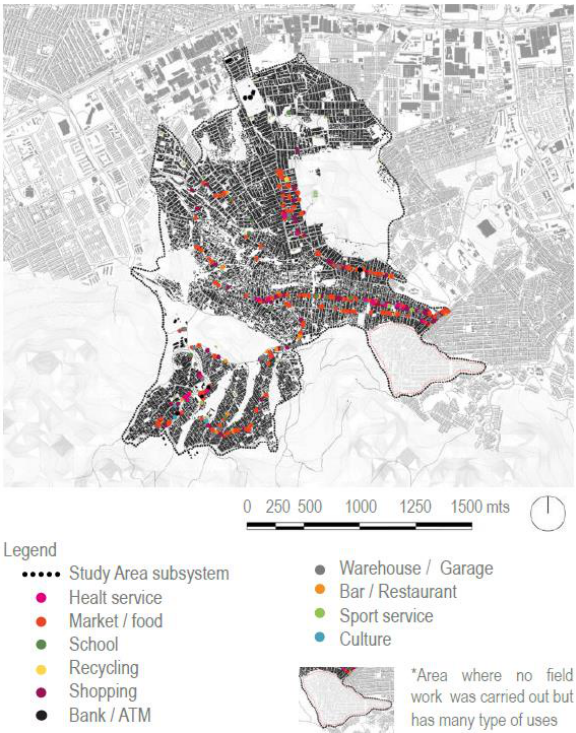
Figure 7 . Map of type of uses.